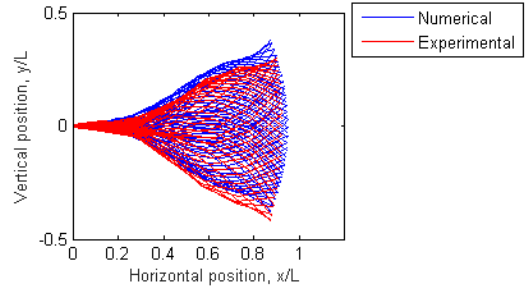
Fig. 6. Numerical and experimental results comparison of the membrane position superimposed every 50 th period.